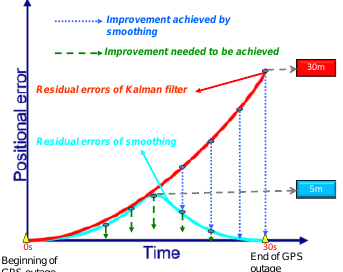
Figure 1 The KF’s positional error behavior during GNSS signal